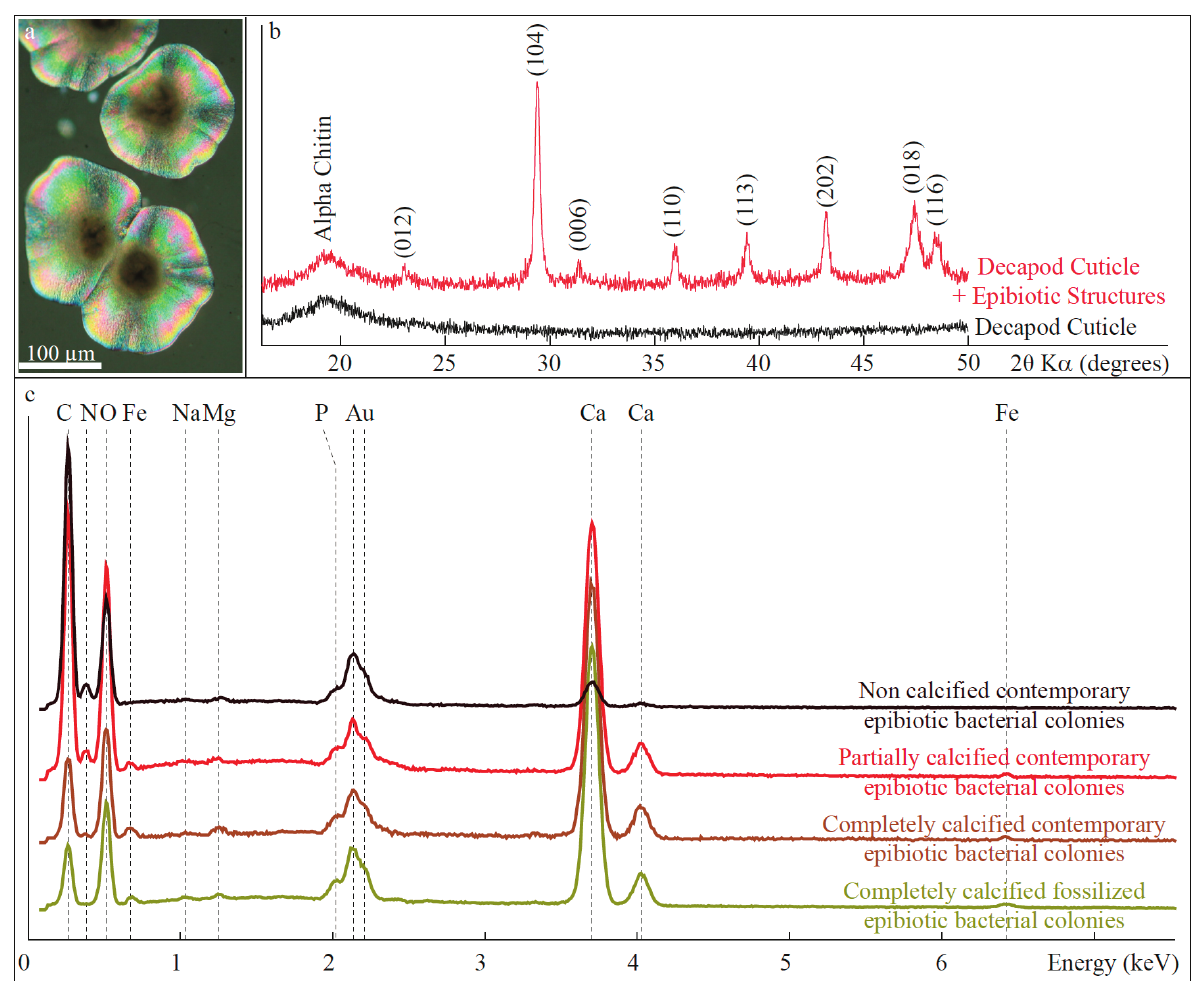
Figure 5. Inorganic composition of the investigated contemporary and fossilized epibiotic calcifying bacterial colonies. ( a ) Photomicrograph of iridescent contemporary specimens of epibiotic calcifying bacterial colonies. ( b ) XRD patterns of contemporary epibiotic calcifying bacterial colonies and of a piece of the host decapod cuticle free of epibiotic bacterial colony. While the host cuticle exhibit an alpha-chitinous signal, contemporary epibiotic calcifying bacterial colonies exhibit peaks consistent with calcite planes. ( c ) EDXS signals of more or less mineralized contemporary and fossilized epibiotic calcifying bacterial colonies. All signals are consistent with Ca carbonates containing small amounts of Fe and Mg. Note that the organics can be identified from the presence of C and N in partially mineralized contemporary and fossilized epibiotic calcifying bacterial